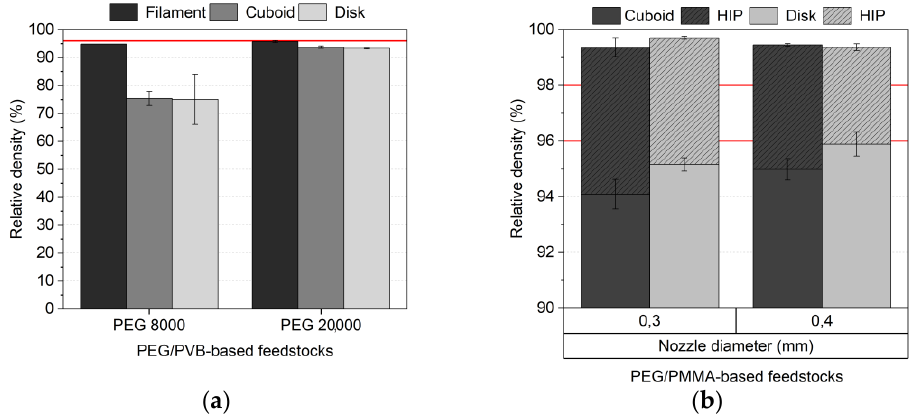
Figure 18. Relative sinter density values (initial solid load 60 vol%) of different FFF-printed test samples: ( a ) PEG/PVB-based feedstocks; ( b ) PEG/PMMA-based feedstocks. Additional densification by HIP marked by hatching. Red lines with respect to values described in ASTM F2884-17 [27].